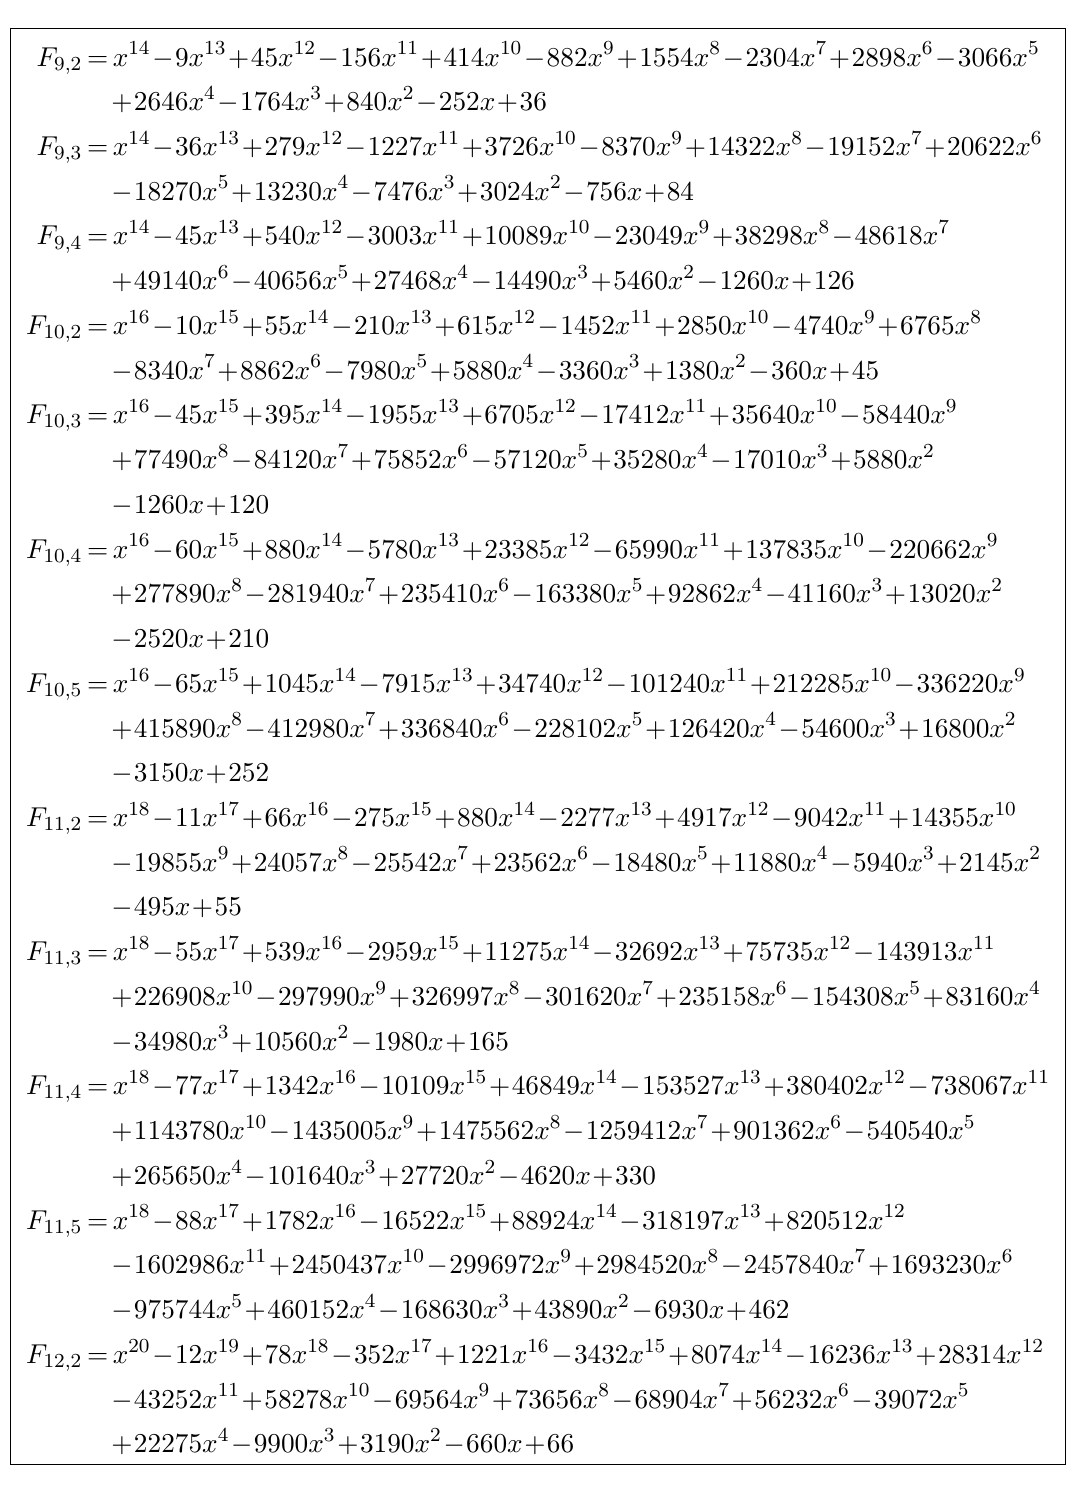
Table 2 . Generating functions for momentum amplituhedron boundaries. Recall that F n;k = F n;n (cid:0) k